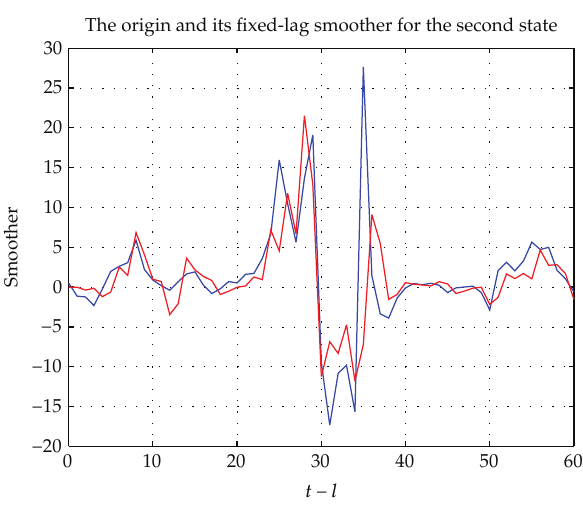
Figure 6: The origin and its fixed-lag smoother (cid:13) x 2 (cid:2) t − l | t (cid:3) , where the blue line is the origin signal, the red line is the smoother.